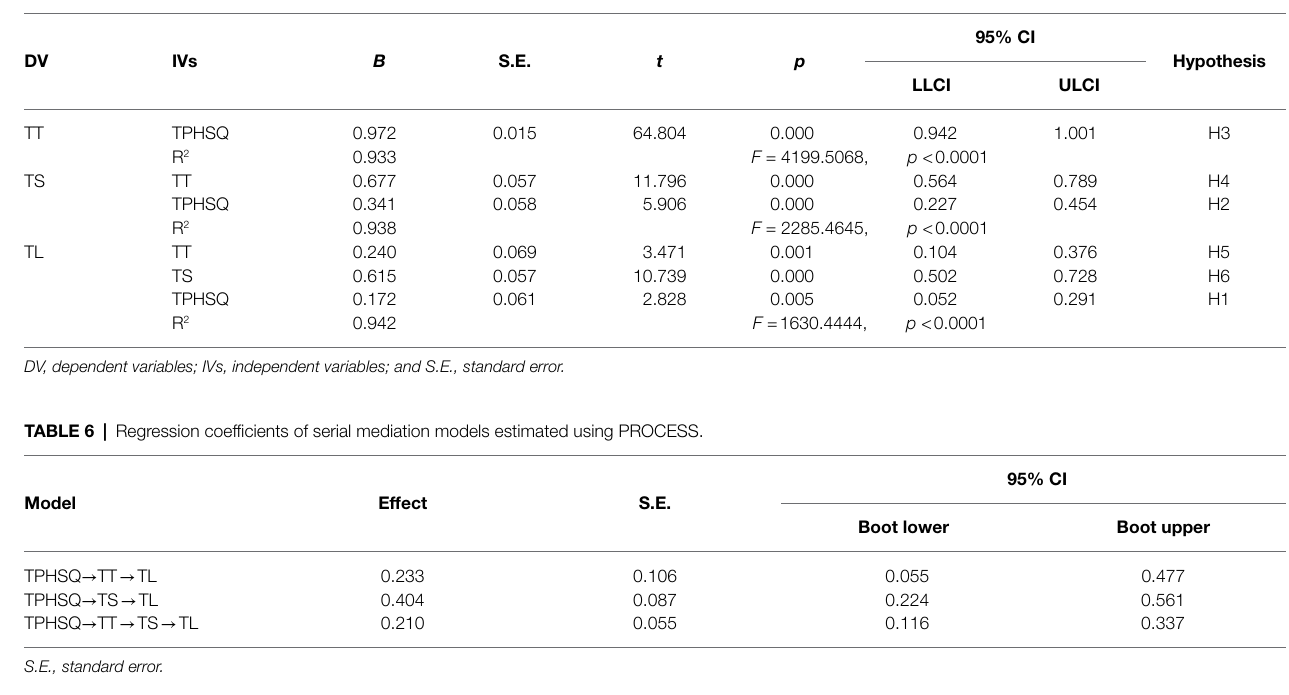
TABLE 5 | Regressions analysis.